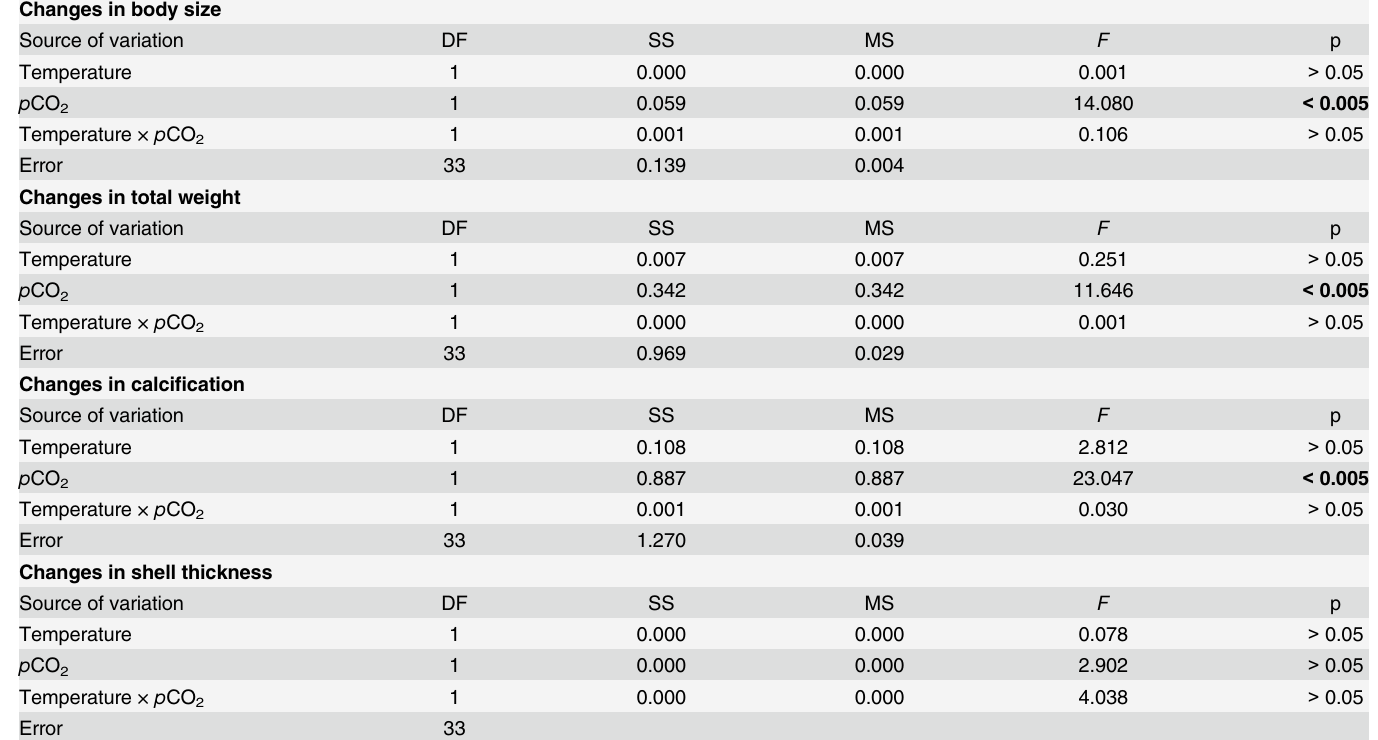
Table 2. Concholepas concholepas. Two-way ANOVAs investigating the effect of different combinations of temperature (15 and 19°C) and p CO 2 (500 and 1400 μ atm) levels on three body traits changes measured in small juveniles after 5.8 months of rearing in the experimental conditions (Fig 2a and 2d). Values in bold are significant at p < 0.05.